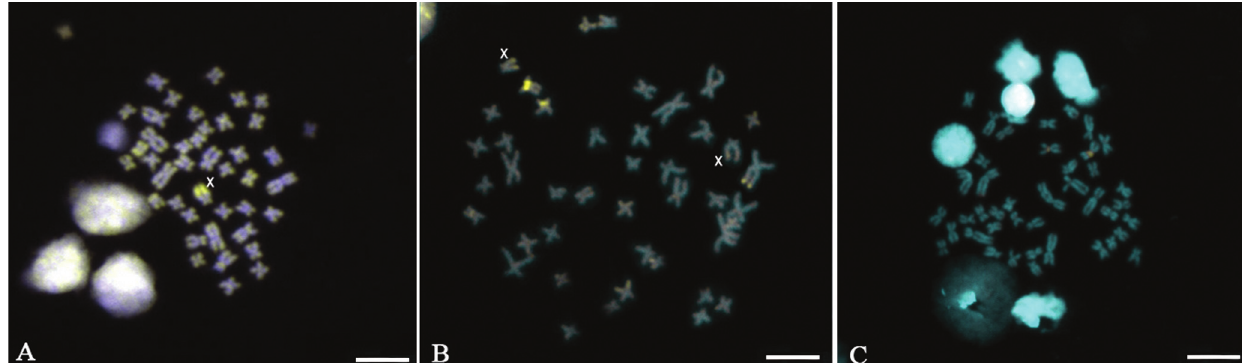
Fig. 4. Patterns of GC-rich regions in H . malabaricus from middle rio Doce lakes. A - karyomorph B male, B - karyomorph B female, and C - karyomorph